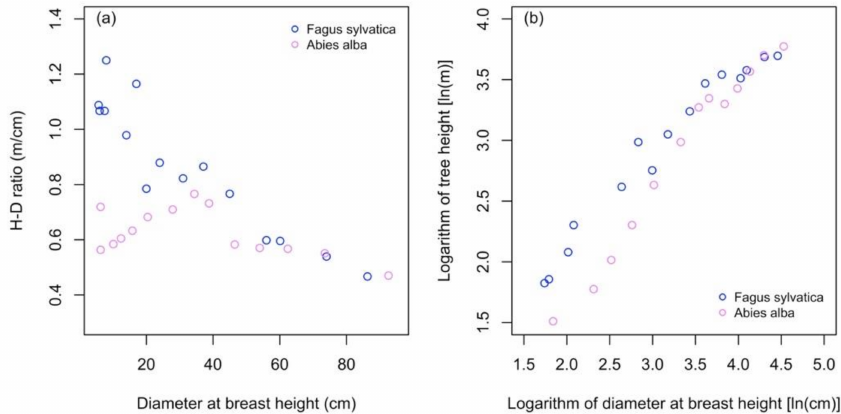
Figure 3. The H-D ratio by D (H is the tree height; D is the diameter at breast height) ( a ) and the relationship between H and D in log-scale ( b ), for European beech and silver fir (site-specific biomass datasets). Note: the plotted trees are from Dataset